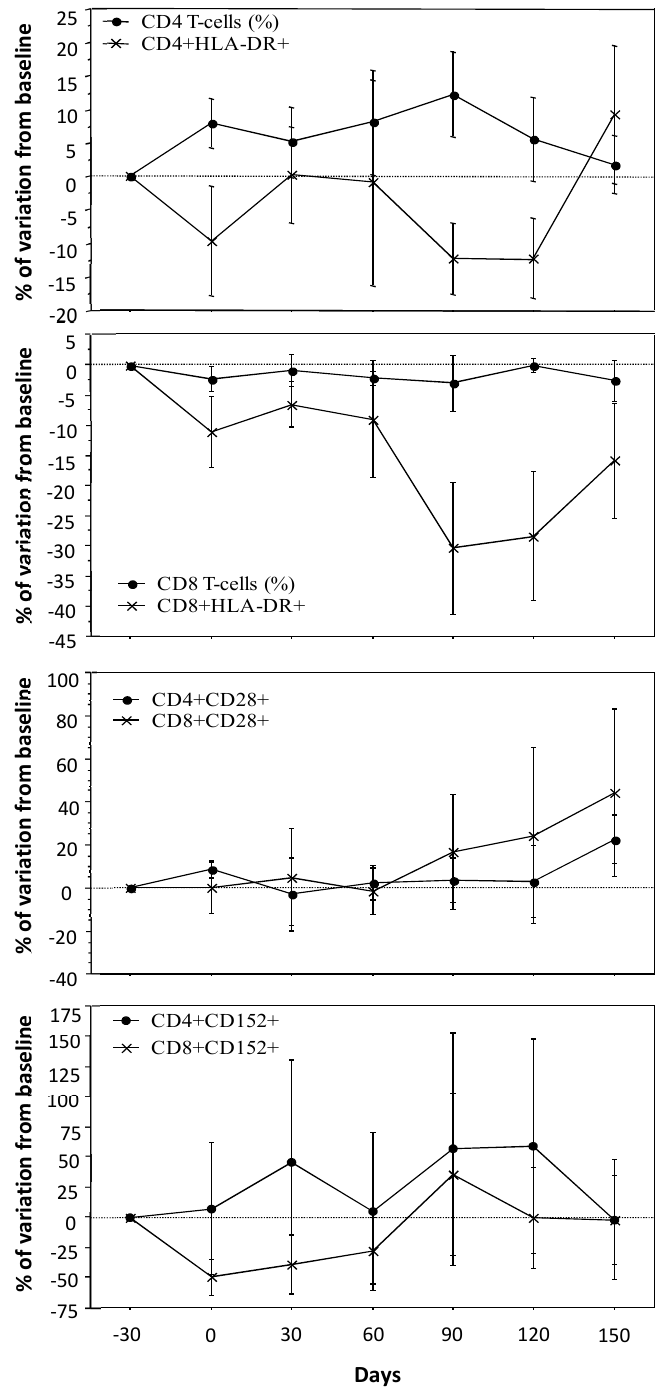
Figure 2. Kinetics of T-cell recovery, activation markers, and costimulatory molecules. T-cell subsets were differently affected during raltegravir inclusion, with a slight increase in CD4 T-cells, con- trasting with a trend towards lower CD8 T-cell count. In both cases, HLA-DR positive T-cells were decreasing with rough up-regulation by the end of raltegravir inclusion. Regarding costimulatory molecules, only CD28 positive T-cells showed a regular slight increase, while CD152 expression was not clearly affected.